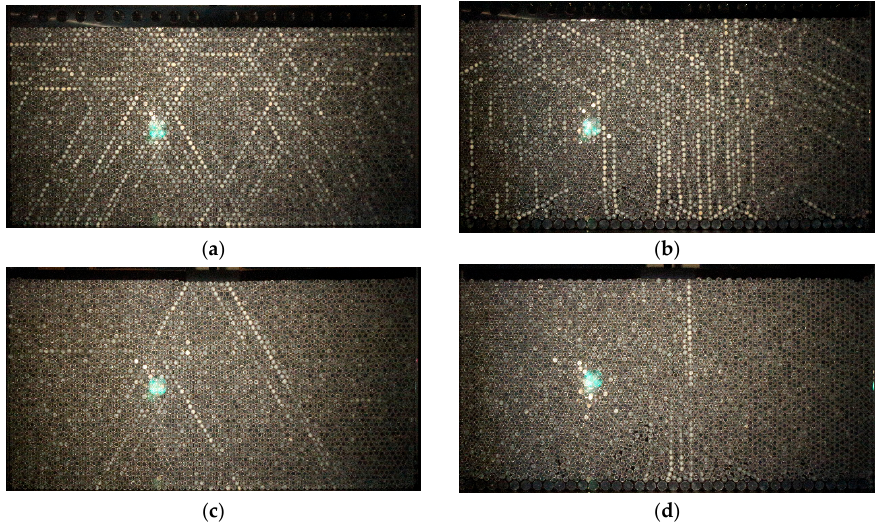
Figure 5. Typical photoelastic images during: (a) uniaxial loading with a uniform structure, F = 2000 N; (b) uniaxial loading with imperfections, F = 2000 N; (c) shallow foundation loading with a uniform structure, F = 400 N; (d) shallow foundation loading with imperfections, F = 400 N.